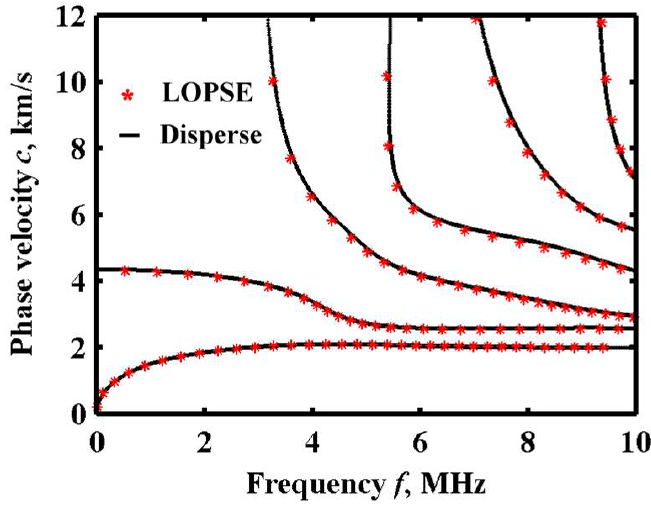
Figure 4. Lamb wave dispersion curve with cutoff order M = 8.